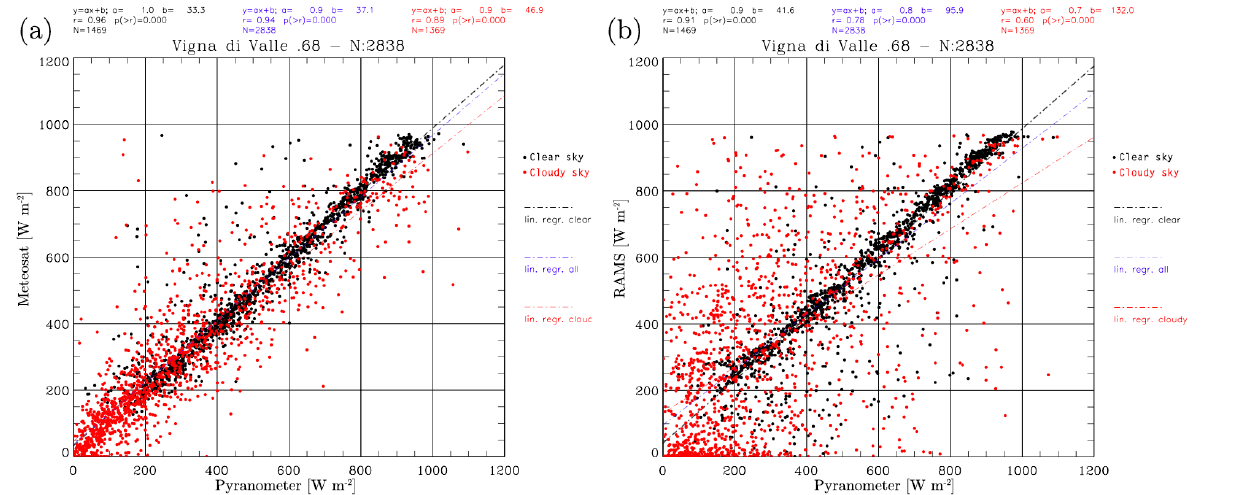
Figure 3. (a) Scatter plot of the GHI for the pyranometer ( x -axis) and MSG ( y -axis) hourly data. The black dots are for clear-sky conditions, while the red dots are for both contaminated and overcast skies; (b) as in (a) for the RAMS 1-day hourly forecast. Regression lines are shown in their respective colours (blue is for all data, i.e. both clear and cloudy